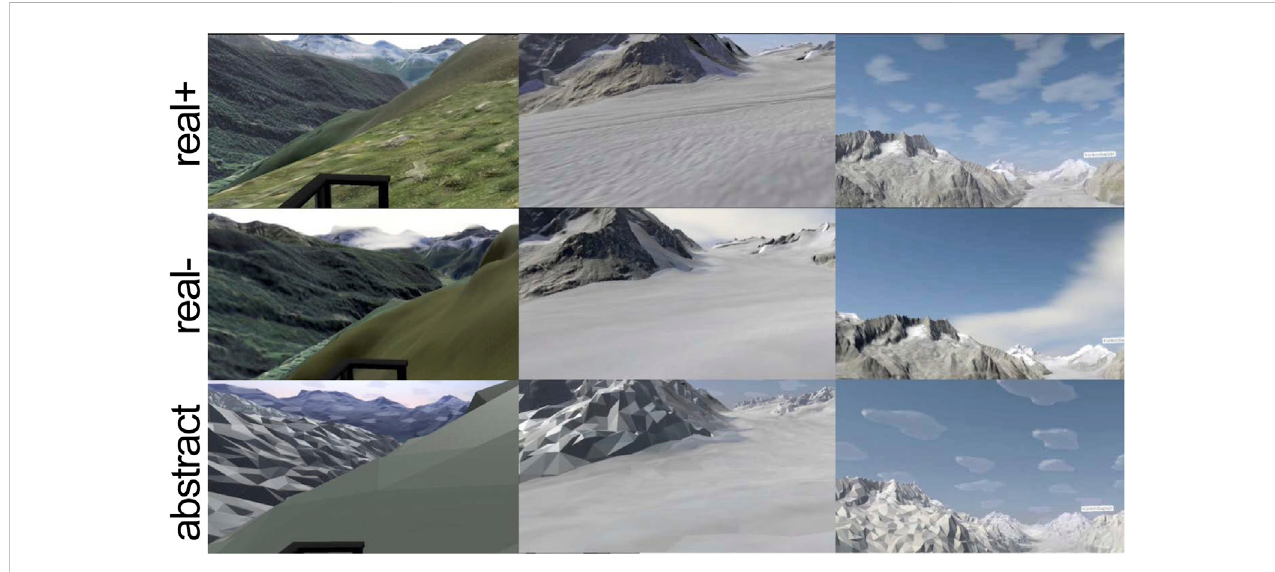
FIGURE 1 Three views each taken from the three different VR